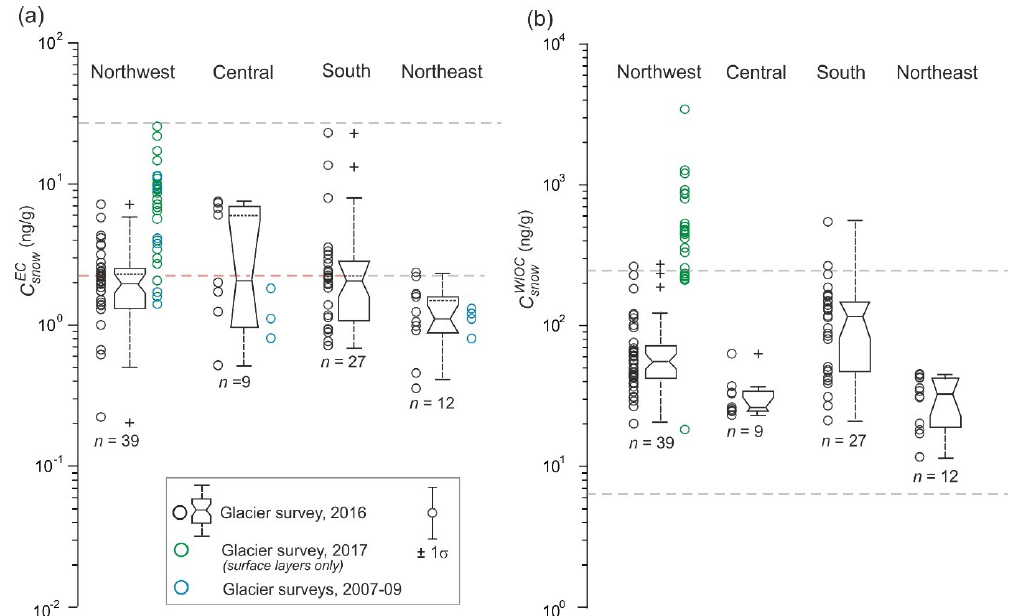
Figure 3. Measurements of (a) C EC snow and (b) C WIOC snow on Svalbard glaciers, grouped by geographic sectors (defined in Fig. 2). The box– whisker plots only include measurements from snowpit samples taken on the glaciers surveyed in April 2016. Box heights give the interquar- tile range, and plus signs (“ + ”) are outliers. Notches bracket the 95% confidence limits on the median. The ± 1 σ error bar in the legend box corresponds to a coefficient of variation of 40% on individual C EC snow or C WIOC snow values. The dotted horizontal traits shown in some of the box plots are the estimated medians if C EC snow values < 1ngg − 1 are excluded. Green circles are C EC snow in surface snow layers sampled on glaciers of northwestern Spitsbergen in 2017 (Table S2), and blue circles are the median values of C EC snow and C WIOC snow in snowpit samples collected on glaciers in 2007–2009 (Forsström et al., 2013). The grey dashed lines bracket the interquartile range of C EC snow and C WIOC snow measured in surface snow layers on the glacier Austre Brøggerbreen, northwestern Spitsbergen, between 2007 and 2018 (this study). ˜ C WIOC (range: 1.8–691.4 ng g − 1 ) between 2007 and snow